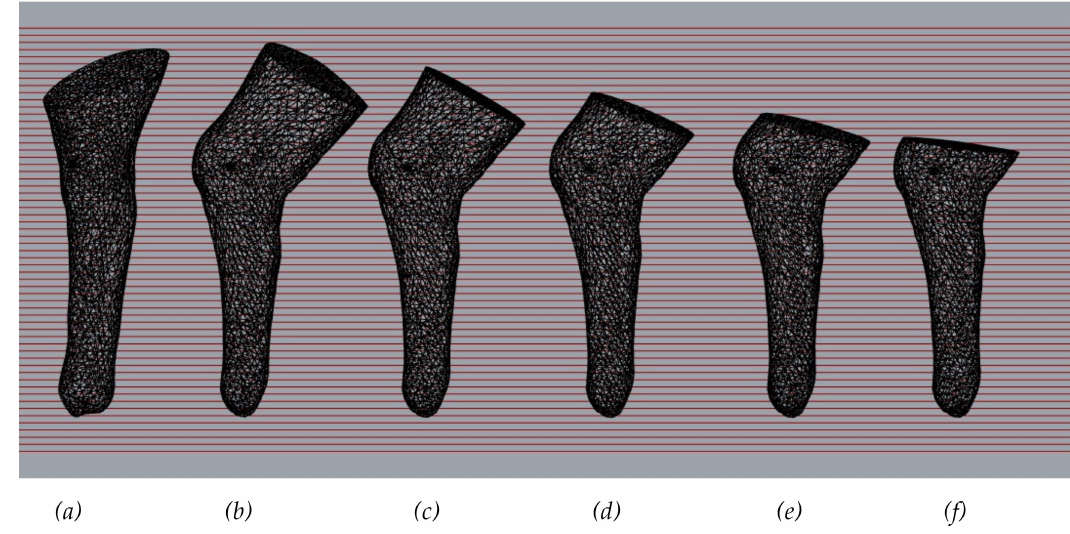
Figure 5. Comparison of models obtained after orientation: ( a ) an expert oriented 3D-model, ( b – f ) 3D-models oriented by the proposed